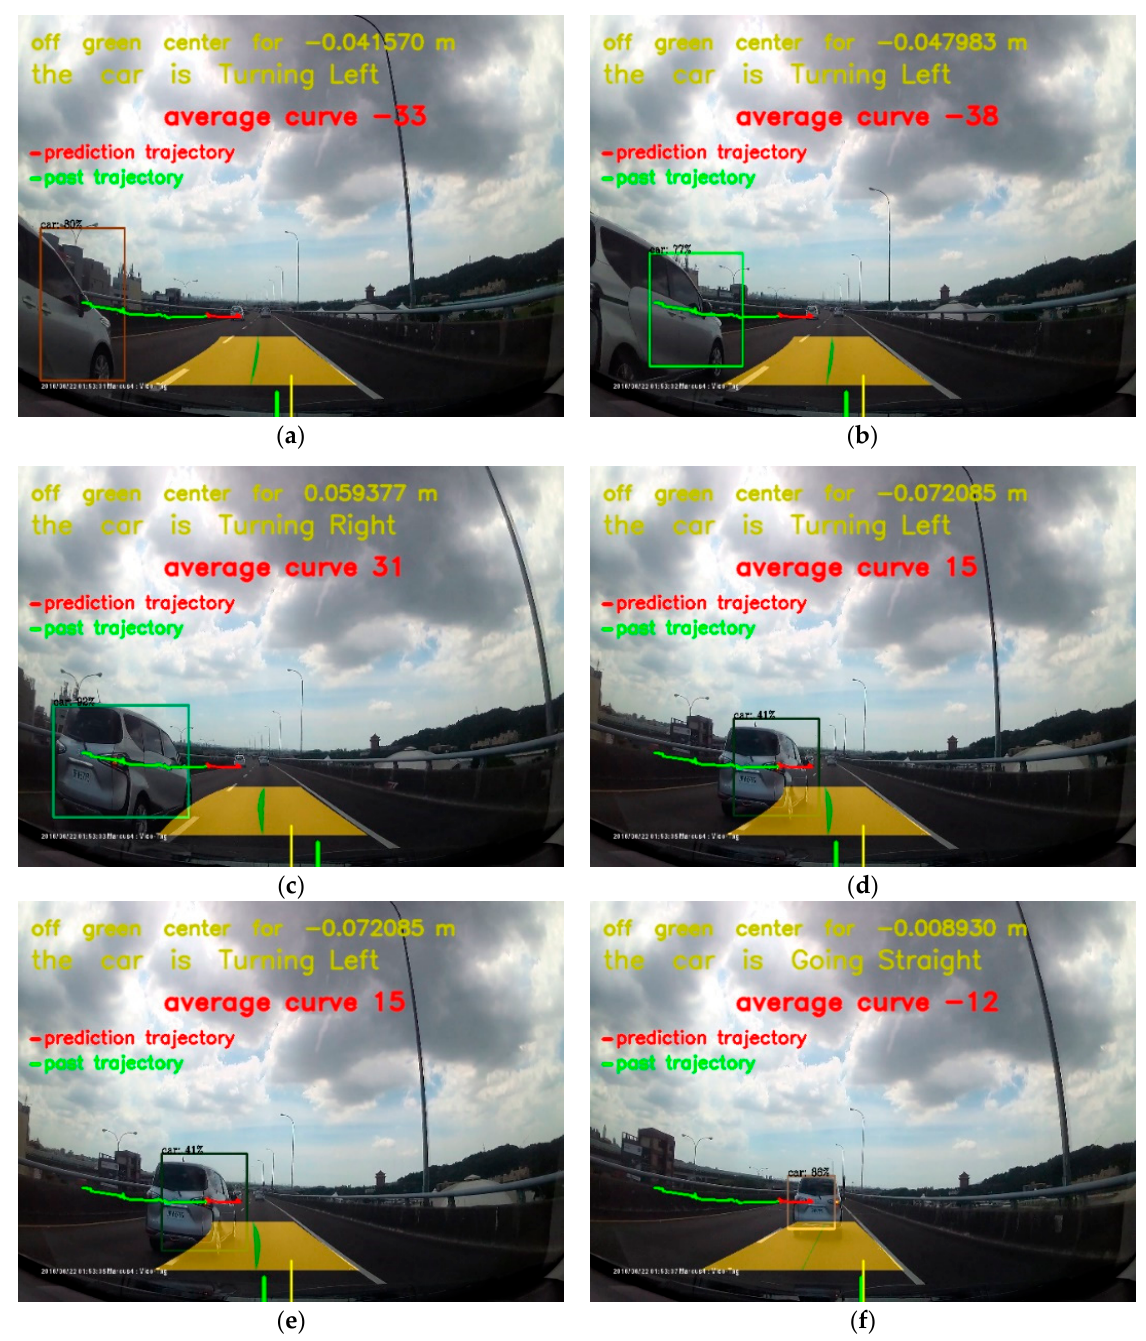
Figure 24. The combination of all techniques of the first validation. We demonstrated the results in three rows: ( a ) the first second the vehicle enters the sight from our left side, ( b – e ) the vehicle moves forward from our left side, ( f ) the last second the vehicle moves forward from our left side.